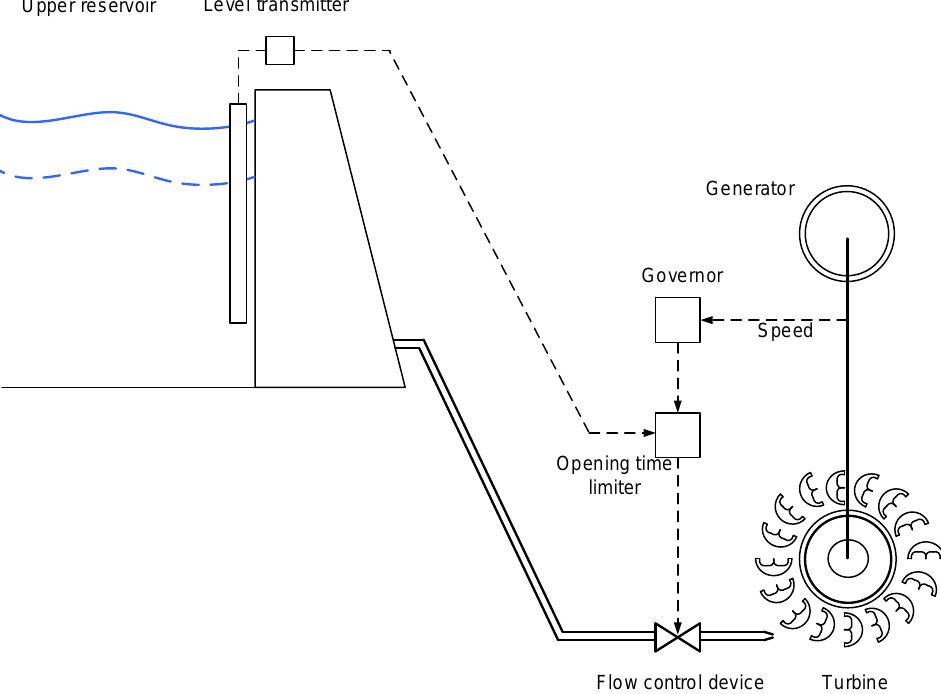
Figure 1. Layout of a turbine flow control depending on the upper reservoir level.